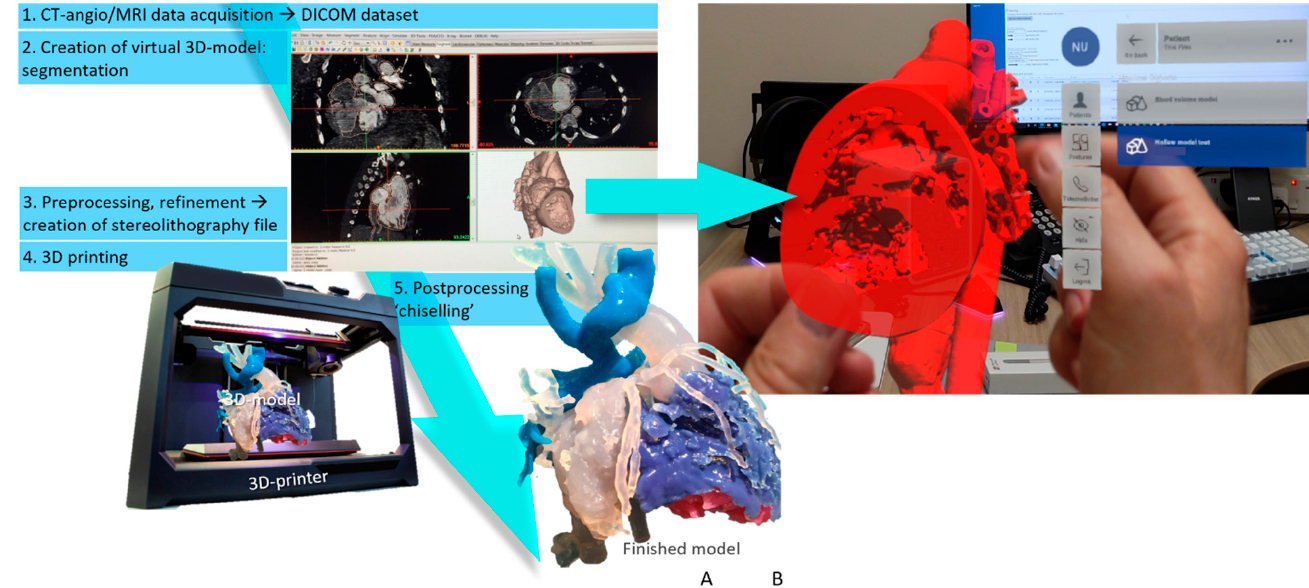
Figure 1. Production phases of 3D modeling for printed prototypes and holograms. ( A ) Digital raw data acquired from imaging sources (CT angiography, MRI) undergo segmentation to create a 3D virtual model. After preprocessing refinement, the stereolithography file is 3D-printed. Models receive postprocessing treatment. ( B ) 3D virtual model as a hologram can also be imported into virtual reality, where it can be fully rotated and entered.